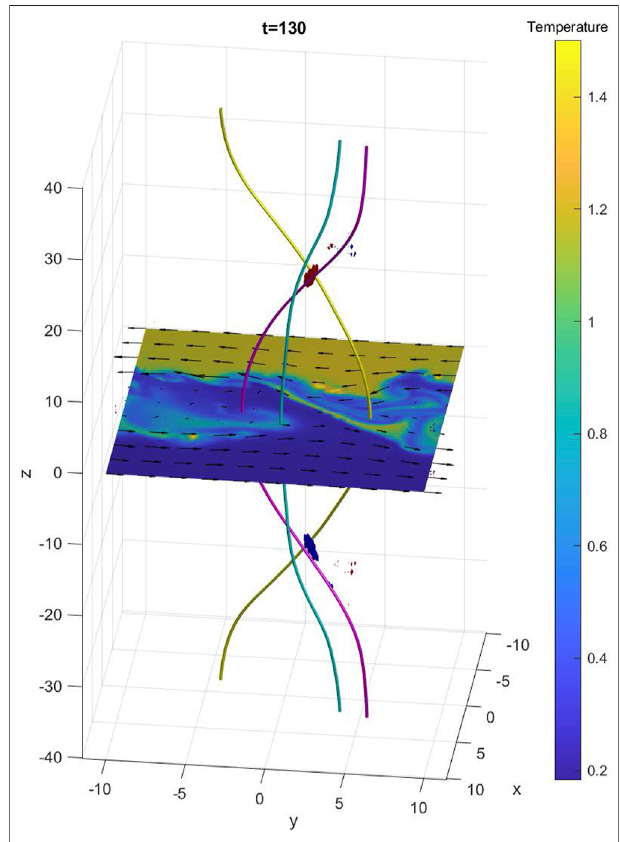
FIGURE 10 | A 3-D MHD simulation rendering for the conditions at time t (cid:1) 130inanonlinear stageoftheKHIcorrespondingtoMMSobservations on 8 Sept 2015 (Ma et al., 2021). A red patch marks a volume of positive fi eld- aligned current density J || > 0.56 U, where 1 U (cid:1) 0.087 uA/m 2 . A blue patch marks a volume of negative J || < − 0.56 U. The magnitudes of the most intense J || ∼ 1.5 U in each patch at this time. A yellow-colored fi eld line is a closed fi eld line traced from (Xs, Ys, Zs) (cid:1) ( − 0.9, 1.5, 19.0) corresponding to the magnetosphere (MSP) side of current layer. A magenta colored fi eld line is an open fi eld line traced from (Xs, Ys, Zs) (cid:1) (0.9, 1.5, 19.0) corresponding to the magnetosheath (MSH) side of current layer. A cyan-colored fi eld line is a newly closed fi eld-line traced from (Xs, Ys, Zs) (cid:1) (2.0, 0.0, 0.0) such that it crosses the plane at the leading edge of the in-plane KH vortex region. A background color index represents the plasma temperature in simulation units. Black arrows show the bulk fl ow velocity on the equatorial plane. Here, the coordinate system is such that Y is positive along the cold MSH tailward fl ow direction, Z is positive northward, and X is positive along the non- perturbed magnetopause CS normal direction.